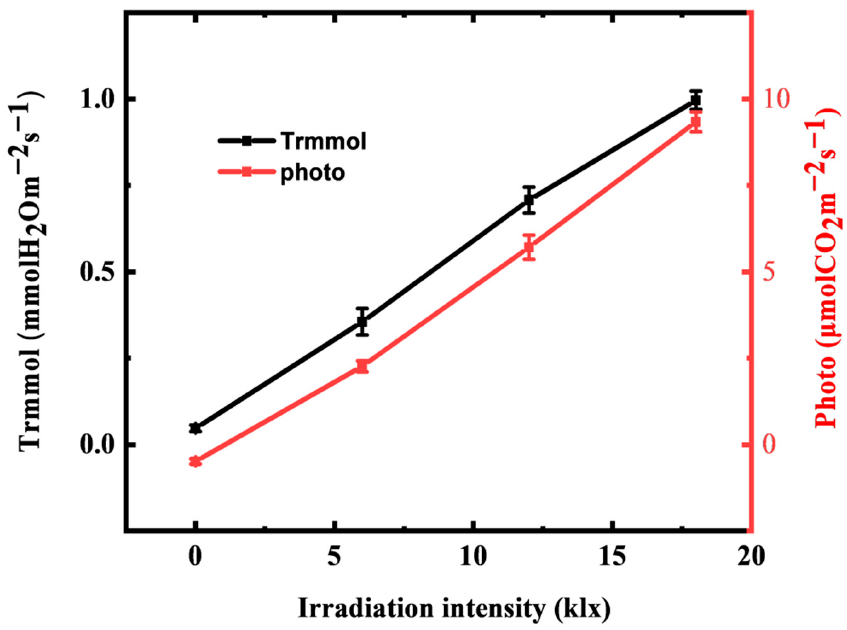
Figure 9. Transpiration rate (Trmmol) and net photosynthetic rate (Photo) of a crop leaf as response to light irradiation intensity.